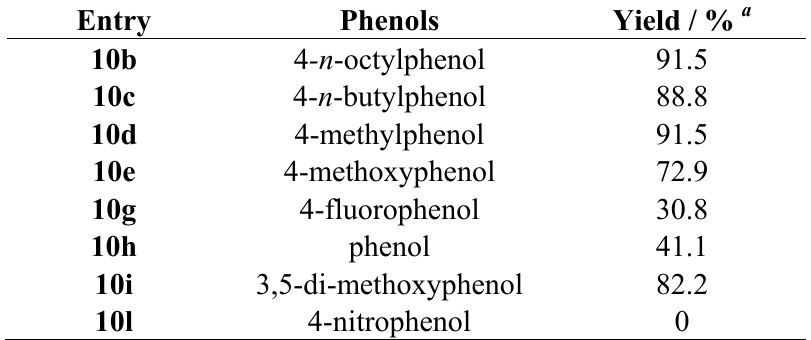
a Isolated yields, estimated from HPLC areas. Reaction conditions: C